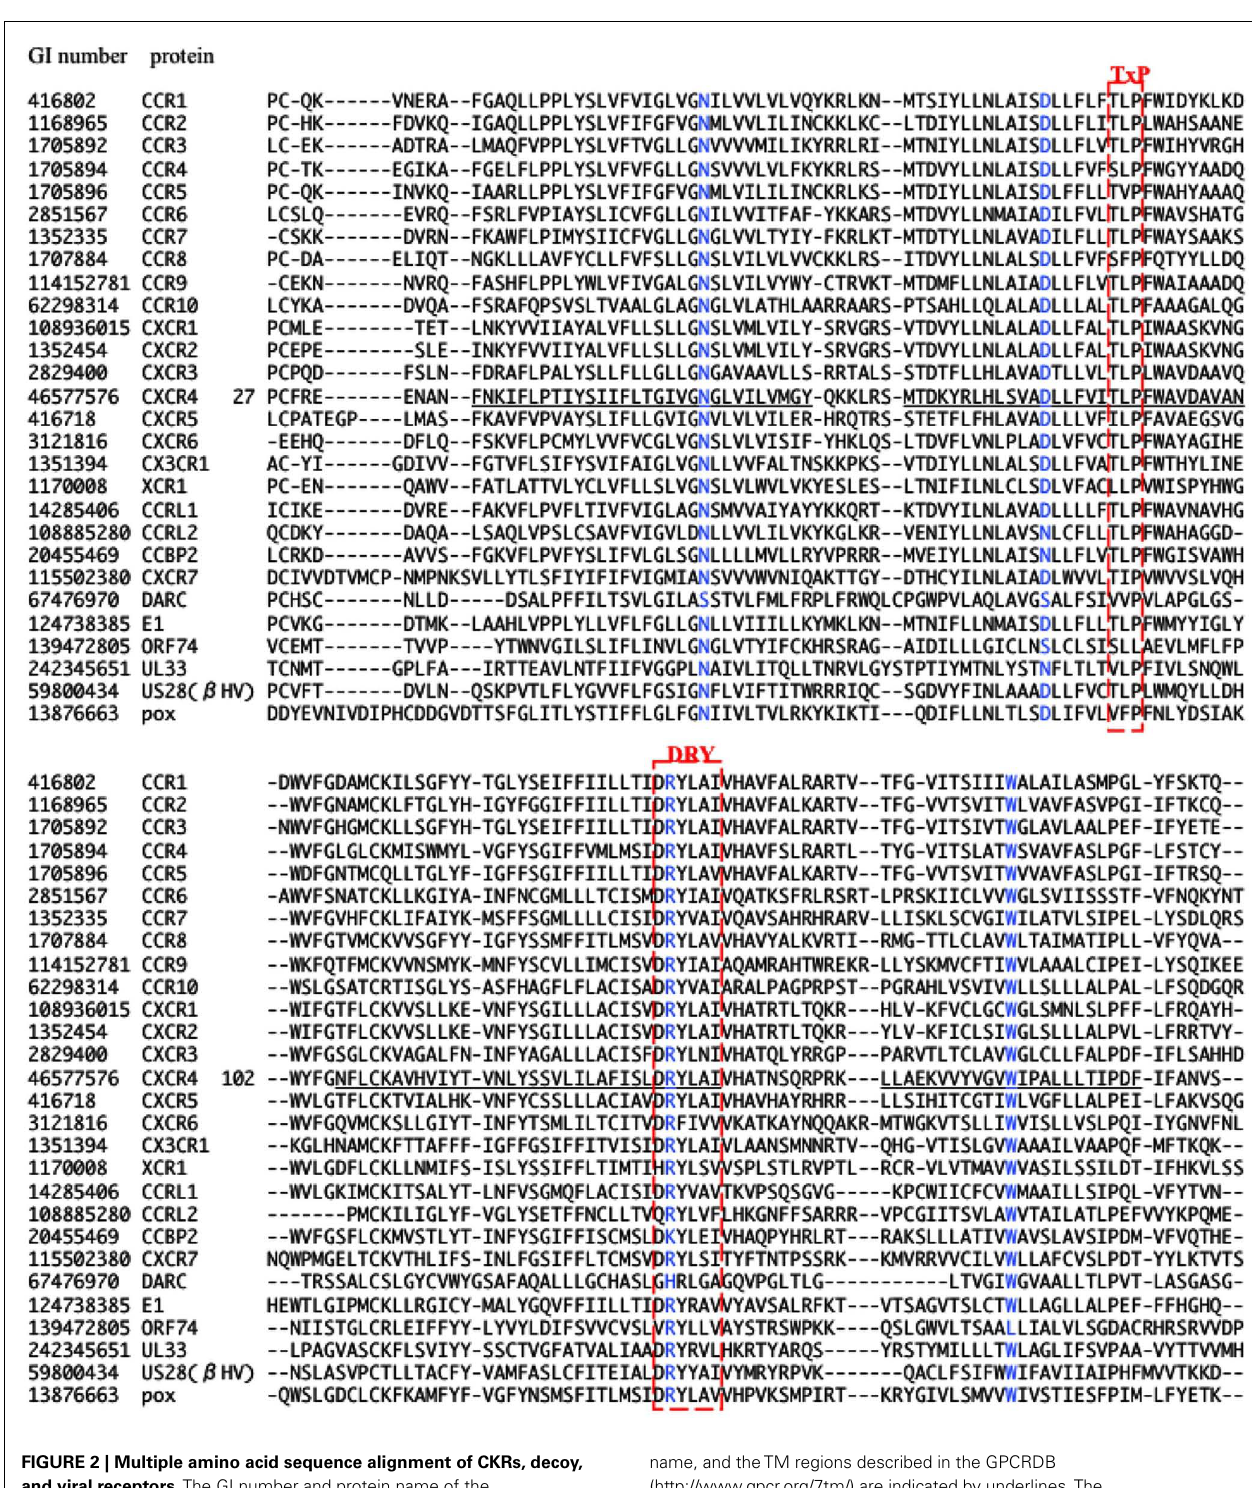
FIGURE 2 | Multiple amino acid sequence alignment of CKRs, decoy, and viral receptors. The GI number and protein name of the representative protein from each group are shown at the left side of the aligned amino acid sequence. In the case of CXCR4, the residue number of the first residue of the aligned sequence is shown after the protein